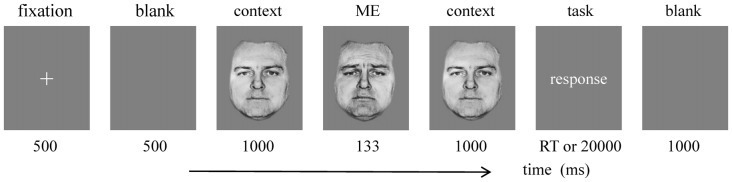
Illustration of one experimental trial.